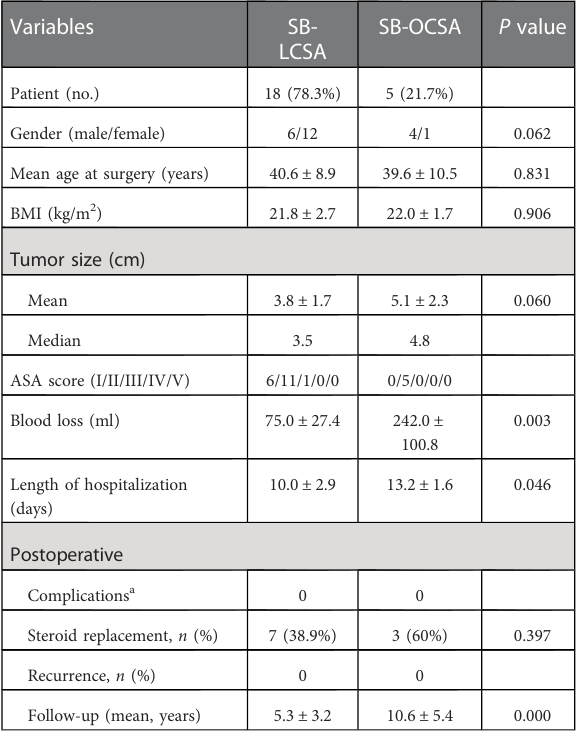
TABLE 3 Presence of perioperation and postoperation in synchronous/metachronous surgery.